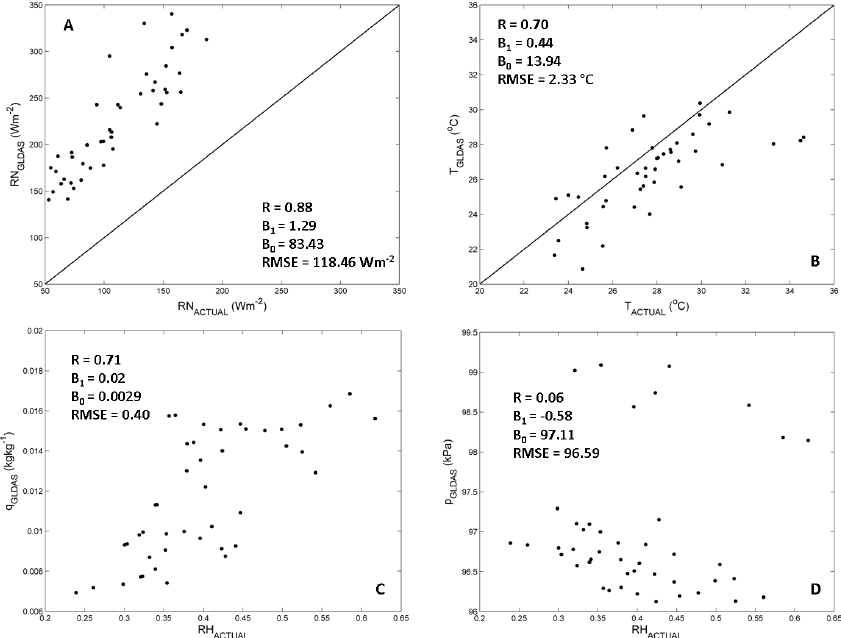
Fig. 2. Plot of Berkeley model inputs from monthly field data versus Noah reanalysis data for ZA-Kru. Net radiation (a) , maximum daily temperature (b) , specific humidity (c) , and surface pressure (d) .